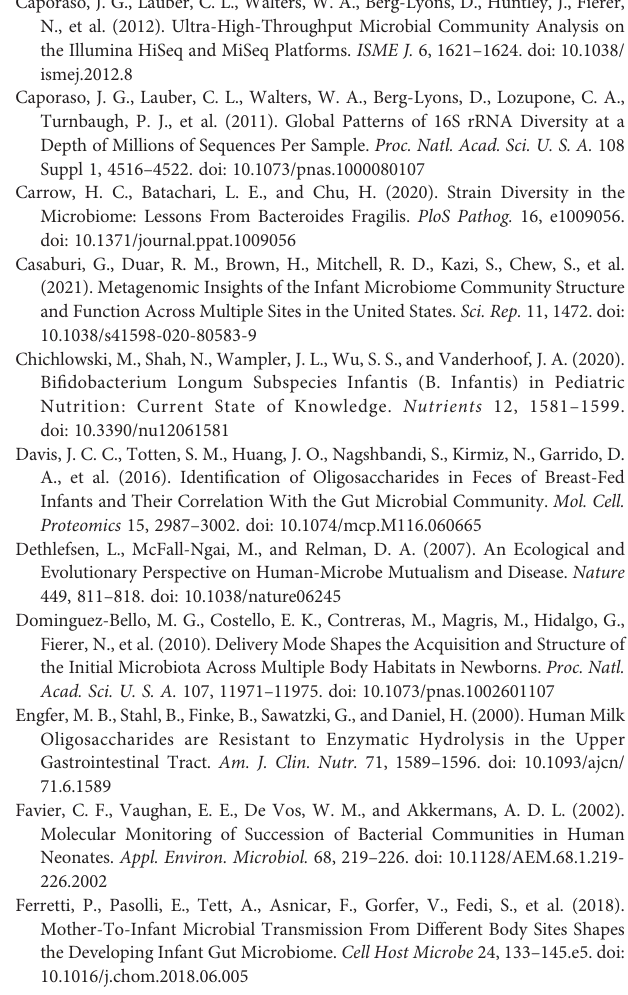
Supplementary Figure 2 | MA plots of HMO transcriptional pro fi les compared to glucose, shown as M (log ratio) on the y-axis and A (mean average) on the x-axis. Here, the log ratio is calculated as the log2 of the change in expression values of the HMOs vs. glucose, and the mean average is of the glucose read counts. Genes from GH families are labeled with larger dots and display the GH family they belong to. The plot highlights up-regulated (red) and down-regulated (blue) genes, using a threshold of 1 for the absolute log2 fold change, and a threshold of 4 for the log2 glucose mean read count. Supplementary Figure 3 | B. dorei ’ s transcriptional pro fi le, as characterized by RNA-Seq experiments, is similar across conditions. The scatterplots display the normalized read count value for all annotated genes in B. dorei ’ s genome (dots), compared between replicates of the same carbon source (diagonal plots) and between different carbon sources (bottom triangle). Pearson coef fi cient was calculated for each comparison. Supplementary Table 1 | Bacterial relative abundances (%) as detected by 16S ribosomal RNA gene sequencing, at the species level. Supplementary Table 2 | B. dorei ’ s transcriptional response upon growth in minimal media (MM) supplemented with various HMOs, compared to MM-glucose. Each sheet represents a different HMO compared to glucose, and the last sheet contains explanations of all columns in previous